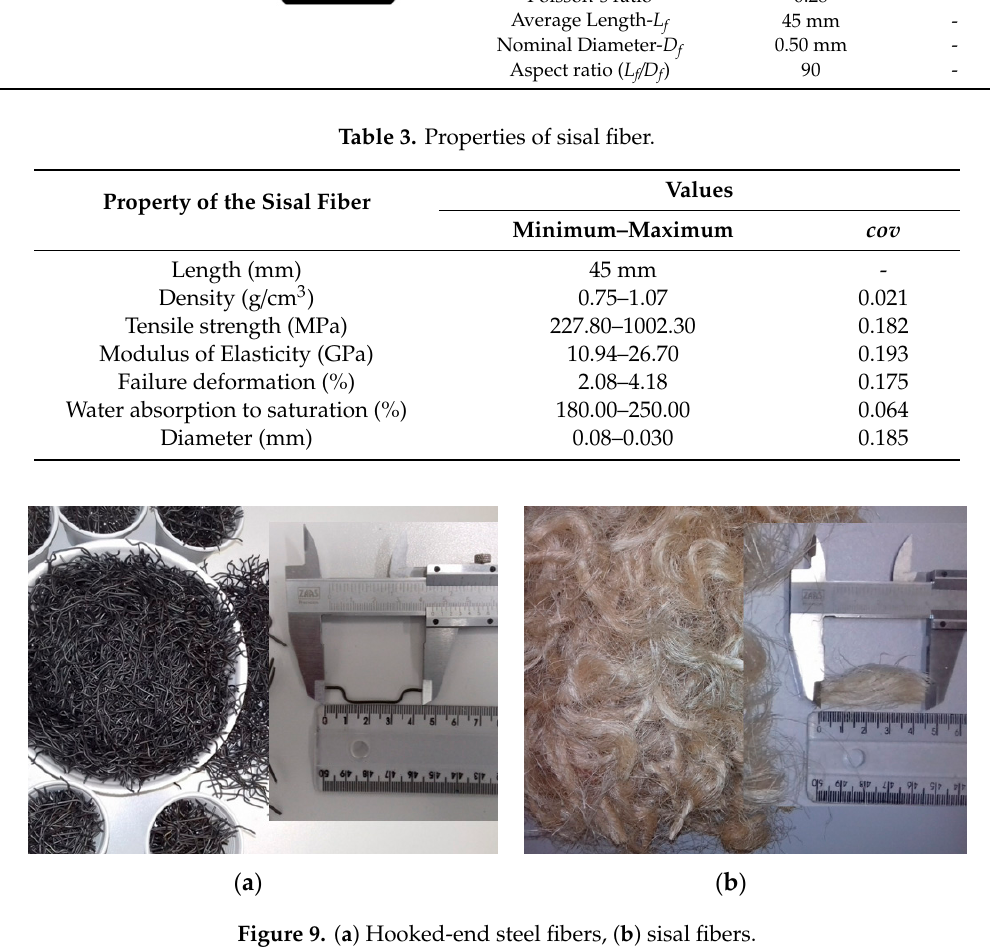
Table 2. Properties of steel fiber.